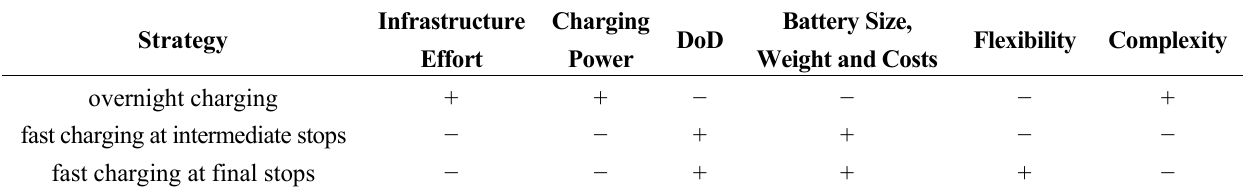
Table 4. Possible operating strategies and their pros (+) and cons ( −